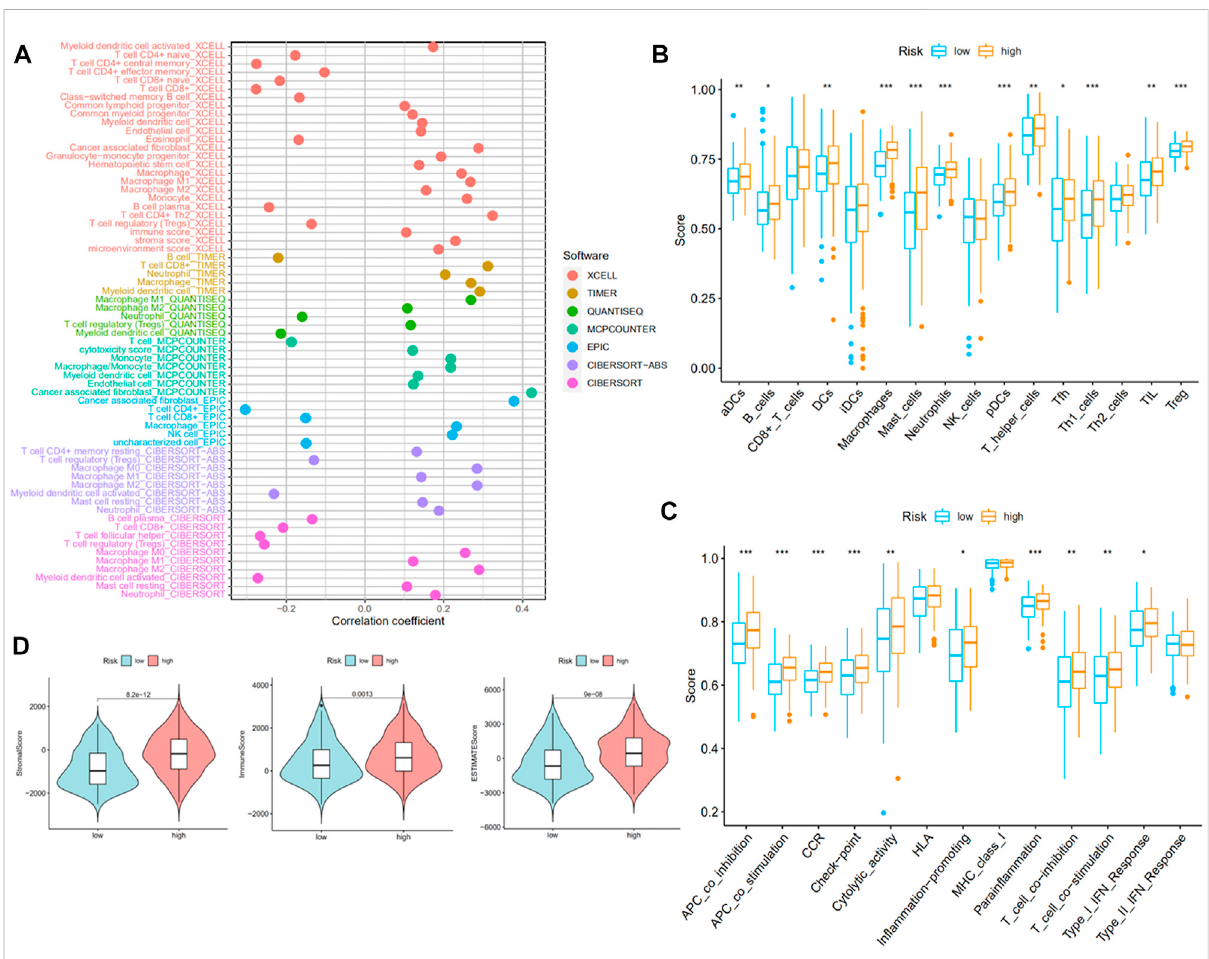
FIGURE 6 Immune in fi ltration of muscle-invasive bladder cancer (MIBC) patients between high- and low-risk groups. (A) The bubble chart presented a correlation between risk score and in fi ltrating level of immune cells. (B,C) The distinction of immune in fi ltrating cells and immune-related functions between low- and high-risk groups. (D) The stromal score, immune score, and ESTIMATE score of the two